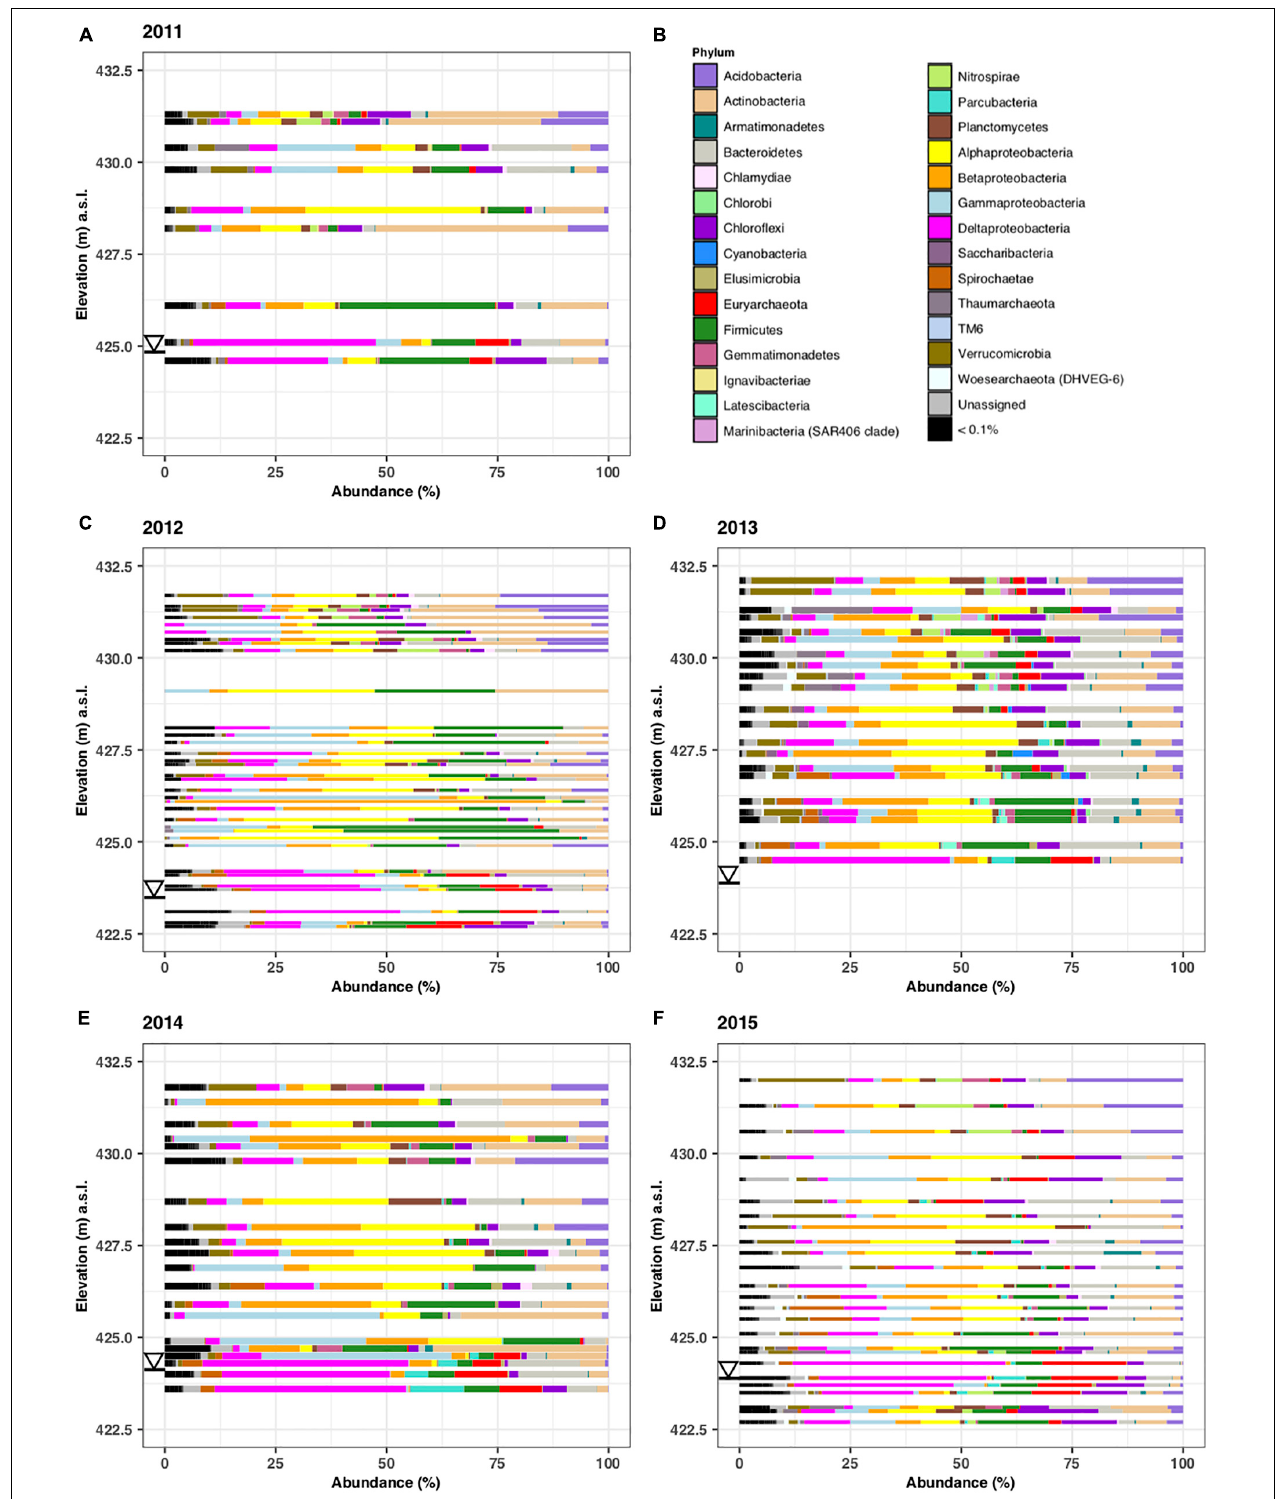
FIGURE 4 | Microbial phyla identified in samples collected along the complete length of sediment cores collected in years 2011–2015. The microbial abundance in % is plotted on the x -axis while the elevation from which the core was taken is plotted in meters above surface level (m.a.s.l.) on the y -axis. Samples were from core C1110 (A) , C1215 (C) , C1308 (D) , C1407 (E) , and C1507 (F) . Only phyla that constituted > 0.1% are shown by name (B) . The triangle denotes the water level in the different years.